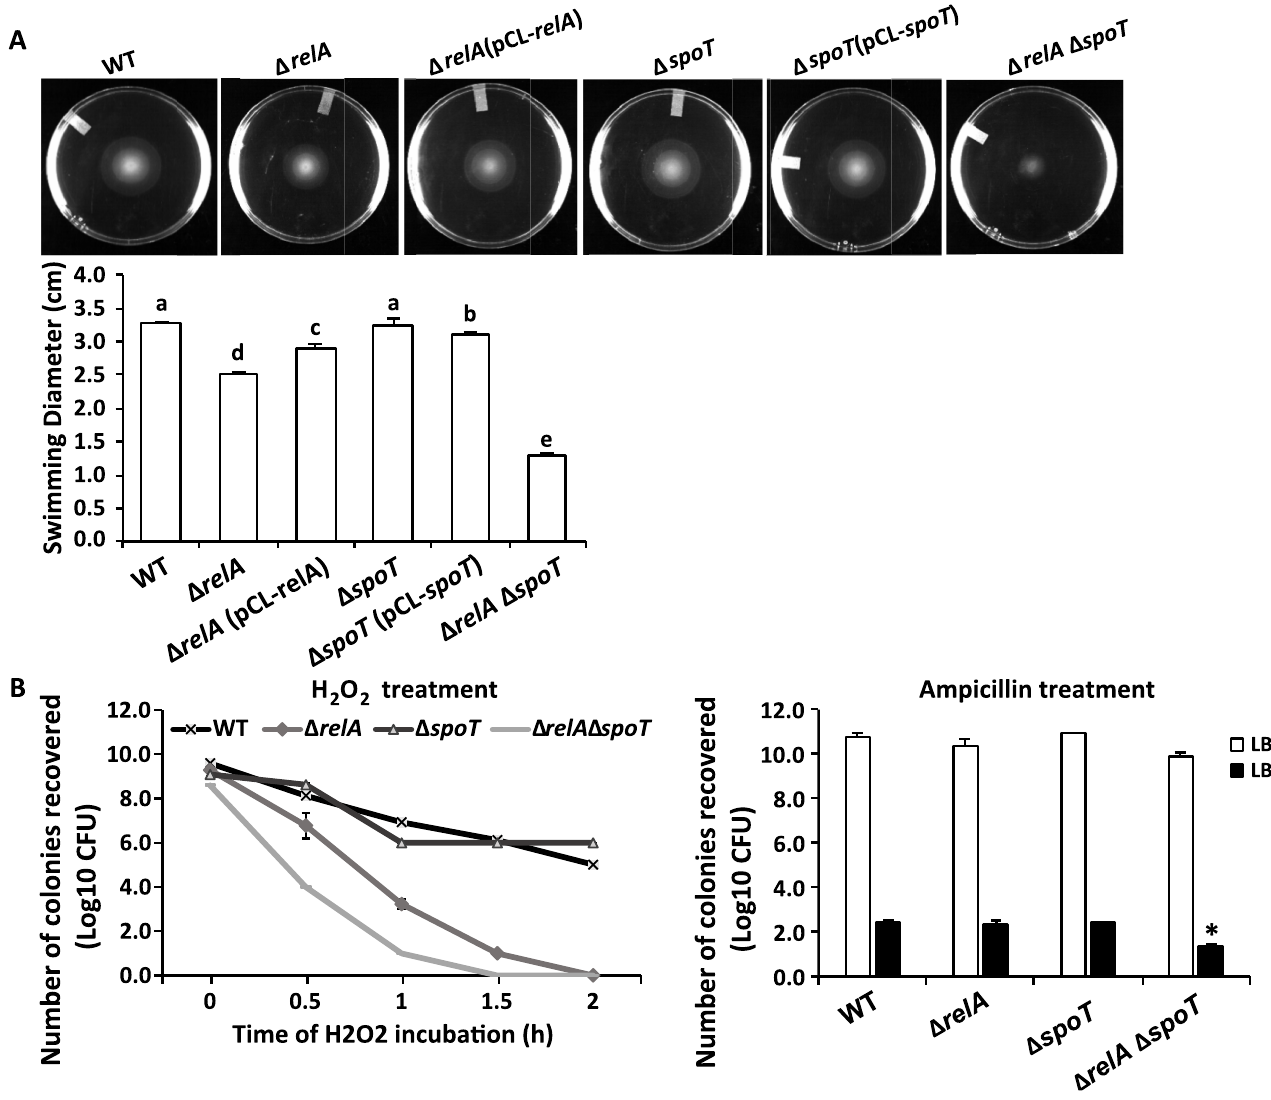
Fig 8. Impact of ppGpp on motility and stress tolerance of D . dadantii . (A) Swimming motility of the wild-type, ppGpp biosynthesis mutants and the complementation strains after 19 hpi. Presence of different letters indicates significant difference ( P < 0.05). (B) Survival of wild type and ppGpp biosynthesis mutants after exposed to 10mM hydrogen peroxide for 0–2 h (left panel) and after plating on LB agar or LB agar supplemented with 1 μ g ml -1 ampicillin for 48 h (right panel). Presence of asterisk indicates significant difference ( P < 0.05). The experiments were repeated three times with similar